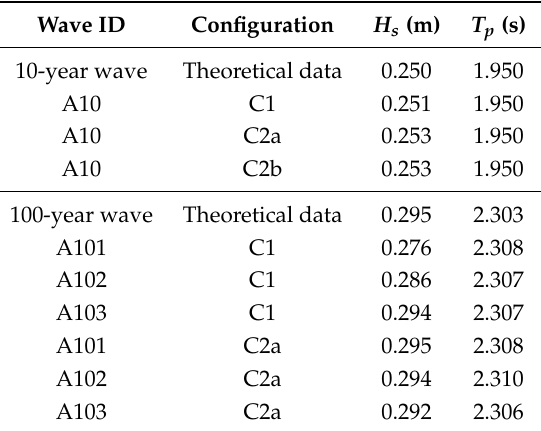
Table 11. Extreme wave records spectral